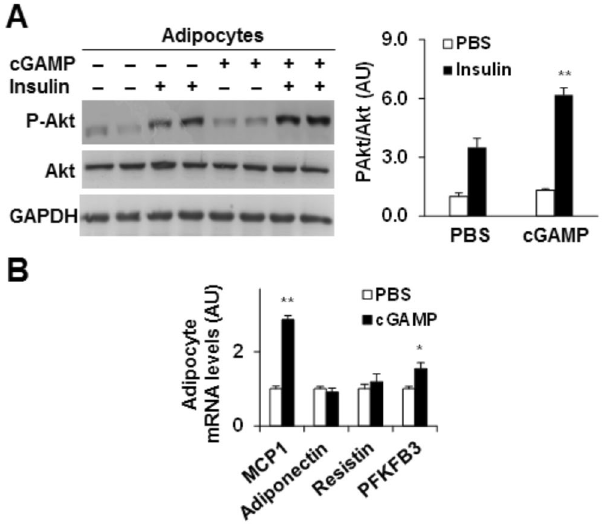
Figure 7. cGAMP improves adipocyte functions. (A) Adipocyte insulin signaling. Cropped blots were displayed. Also, full-length blots were included in Supplemental Information (Figure S19). ( B ) Adipocyte gene expression. For A and B, differentiated 3T3-L1 adipocytes were treated with cGAMP (20 mg/ml) or PBS for 24 hr. For A, prior to harvest, adipocytes were treated with or without insulin (100 nM) for the last 30 min. Cell lysates were examined for the phosphorylation and total amount of Akt using Western blot analysis. Blots were quantified using densitometry. For B, the mRNA levels of adipocyte genes were quantified using real-time PCR. For bar graphs, data are means ± S.E. n = 6. * P < 0.05 and ** P < 0.01, cGAMP vs. PBS under the same condition (Insulin-stimulated condition in A) for the same gene (in